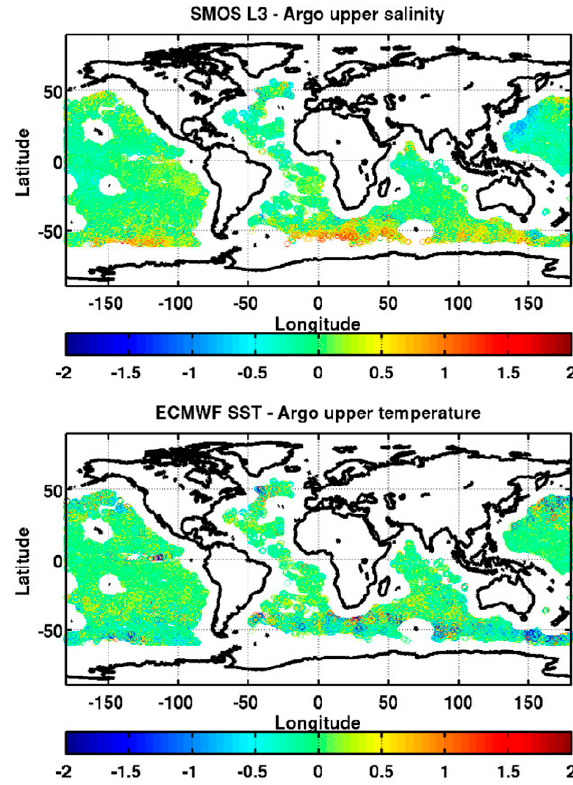
Fig. 10. – Spatial distribution of the differences between SMOS and Argo surface value (top) and spatial distribution of the differences between OSTIA SST and the Argo upper temperature